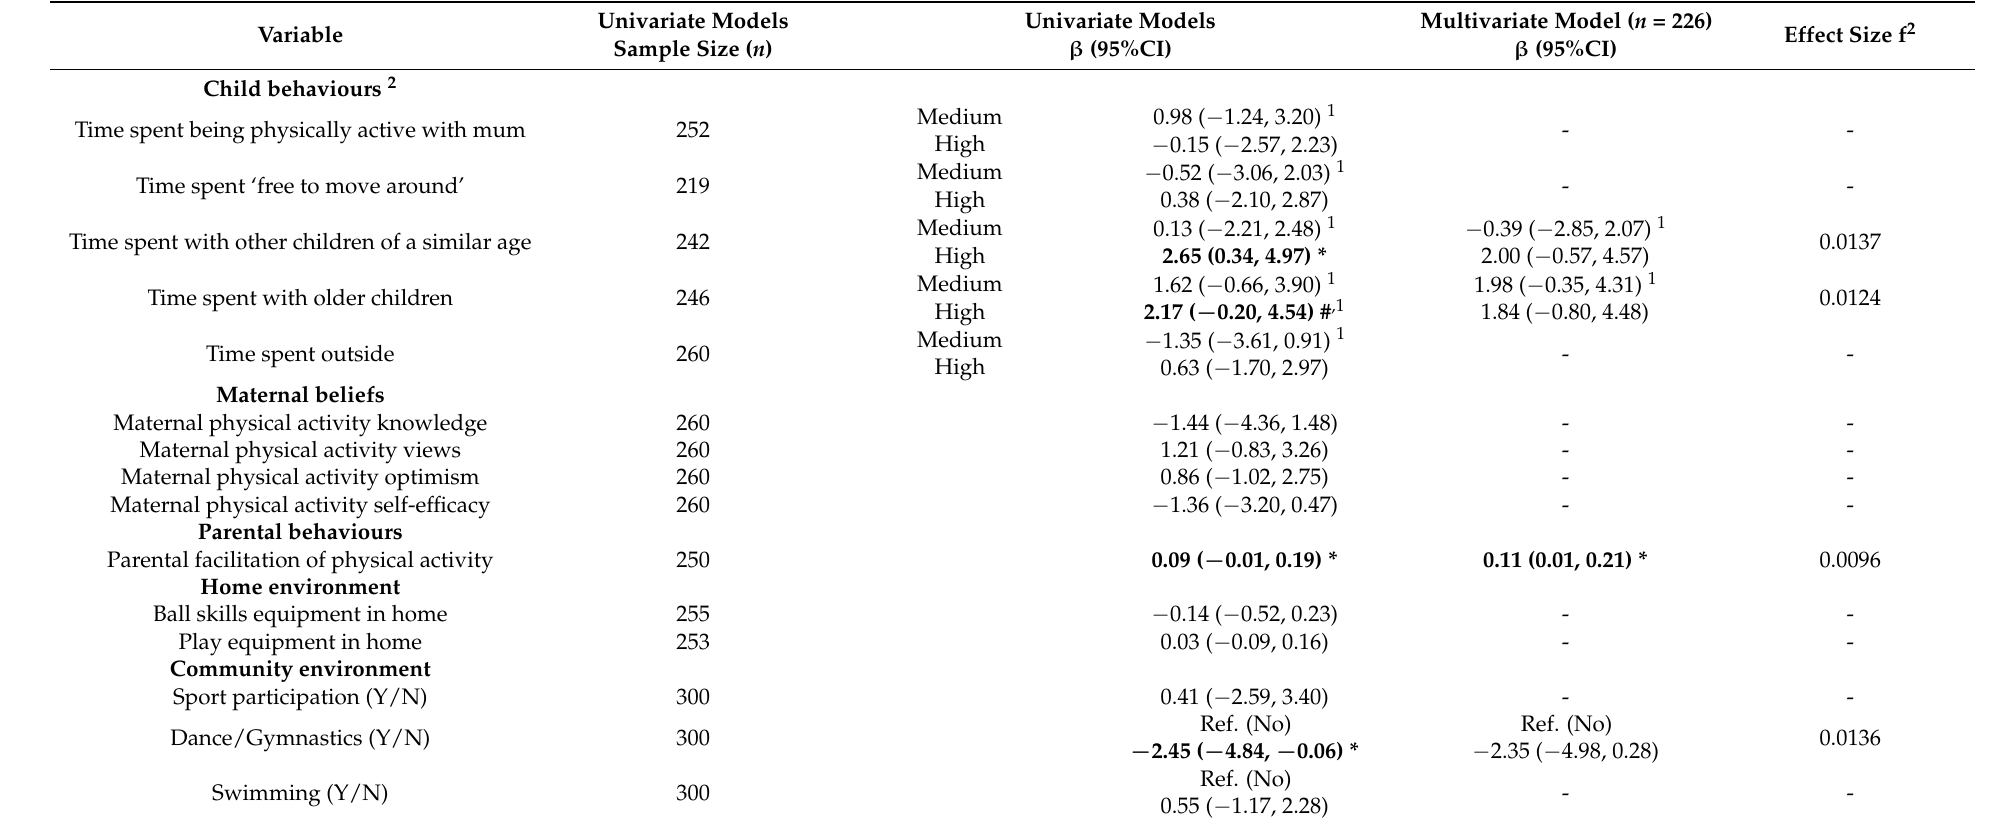
Table 3. Predictors of 3.5-year-old children’s perceived motor skill competence (PMSC) at 5 years old 1